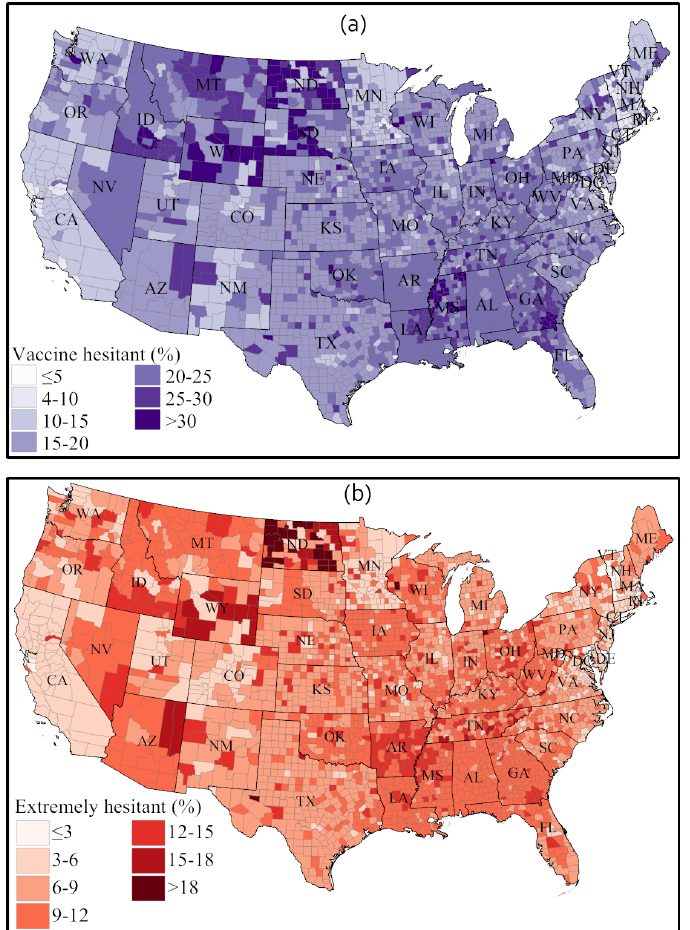
Figure 15. ( a ) COVID-19 vaccine hesitancy (%) in US counties; ( b ) COVID-19 vaccine extreme hesitancy (%) in US counties (Data source: